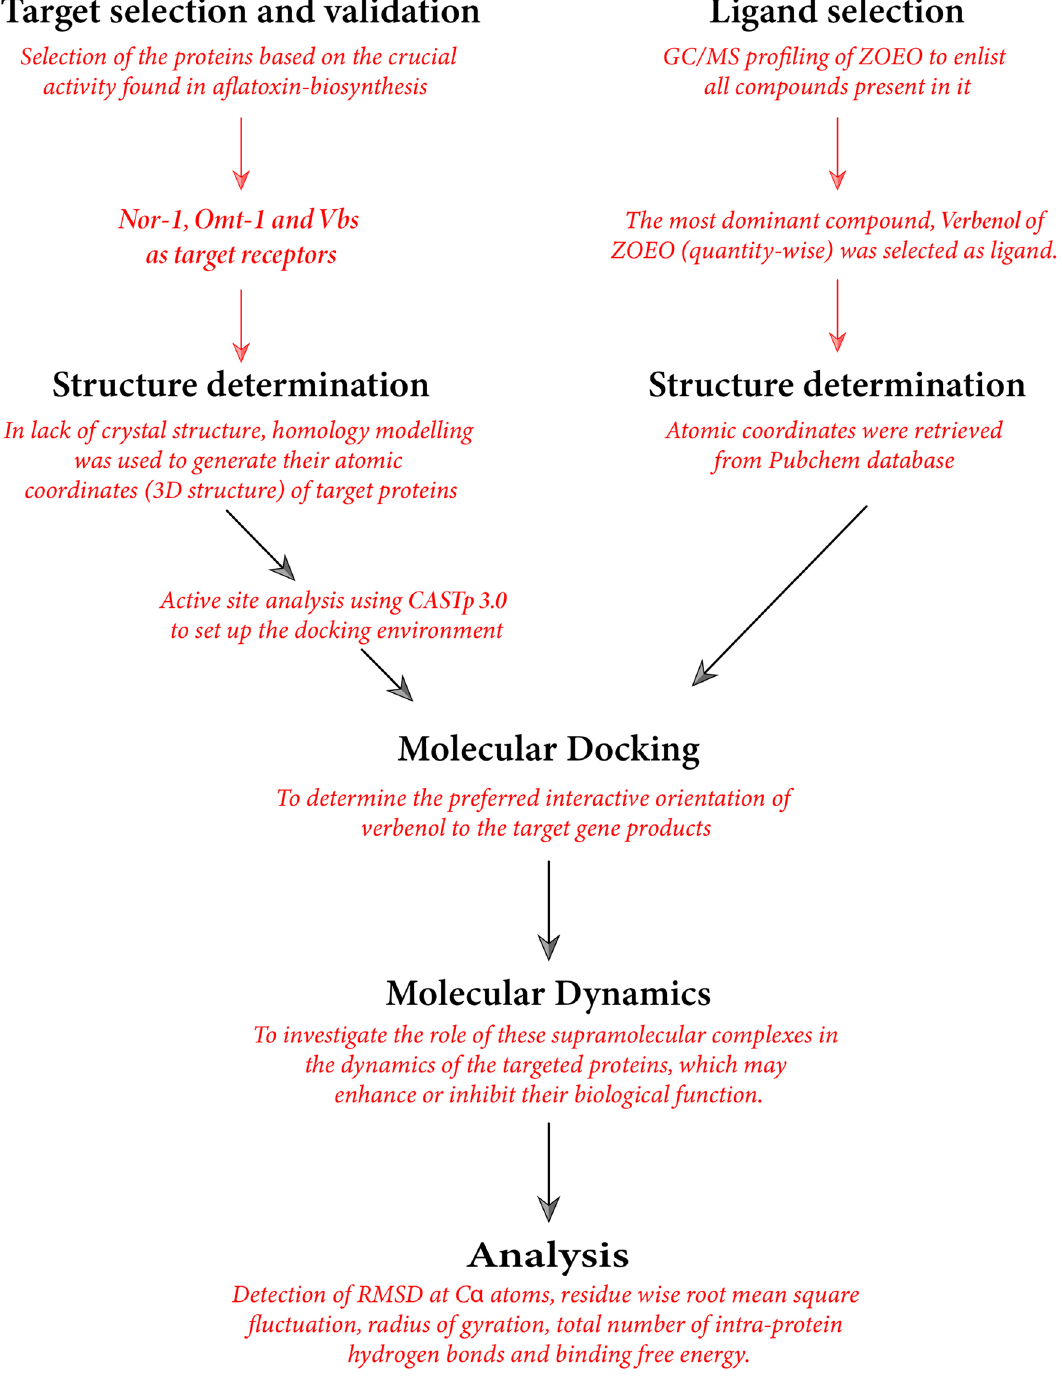
Figure 1. Methodological scheme summarizing the flow-chart of computational